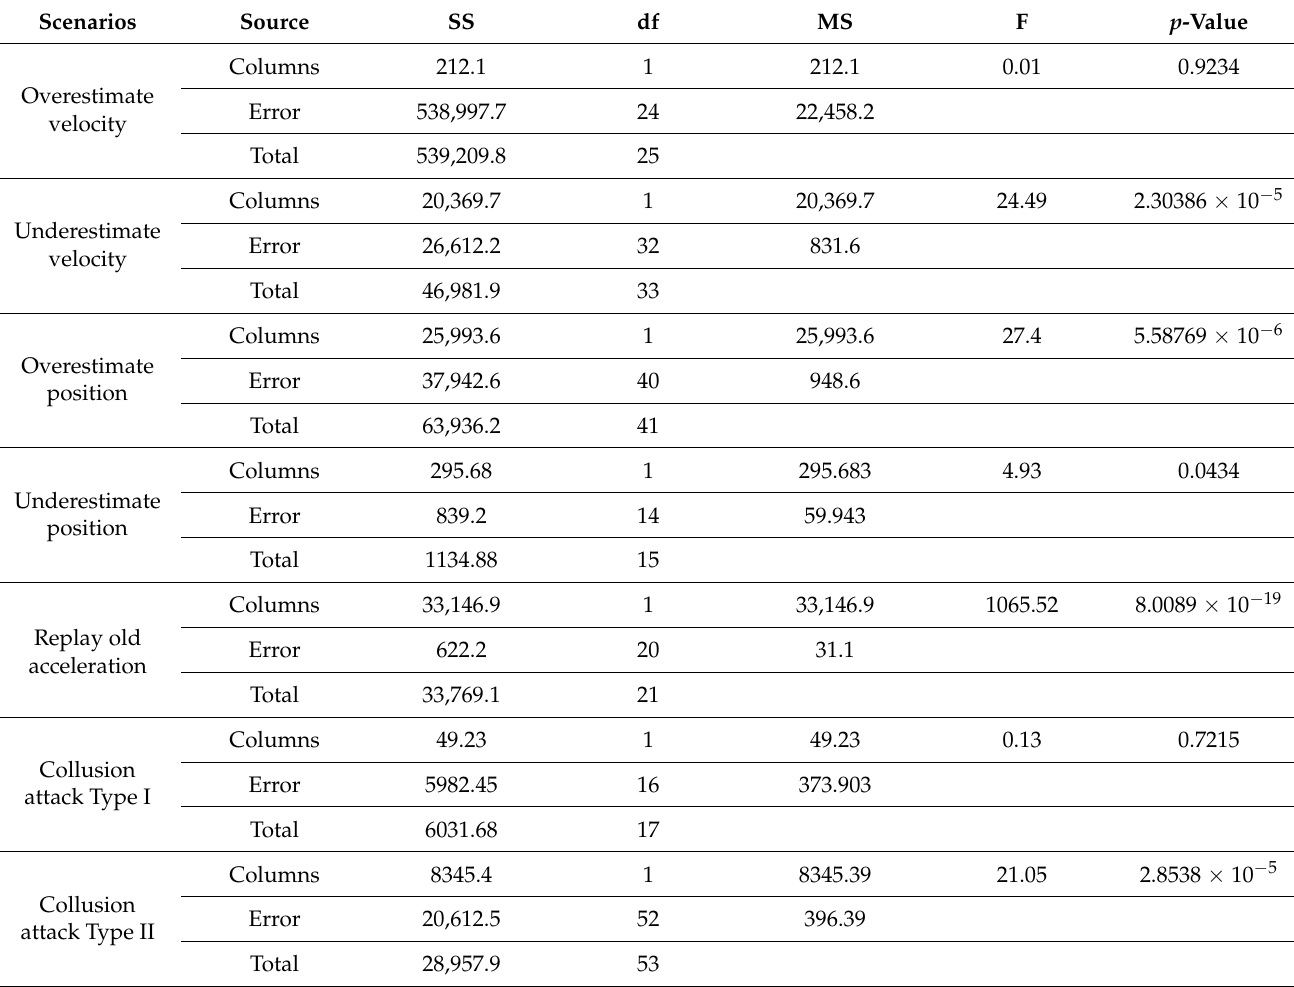
Table 7. One-way ANOVA with or without RRCS under different cyberattacks